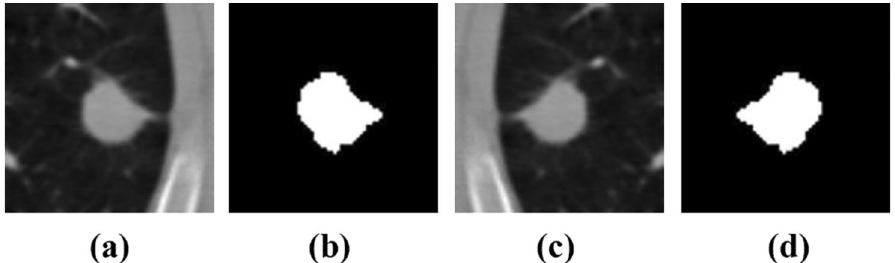
Figure 4. Sample Nodule Patch and Augmented Nodule Patch with Ground Truths. ( a ) Nodule Patch ( b ) Ground Truth ( c ) Augmented Nodule Patch ( d ) Augmented Ground